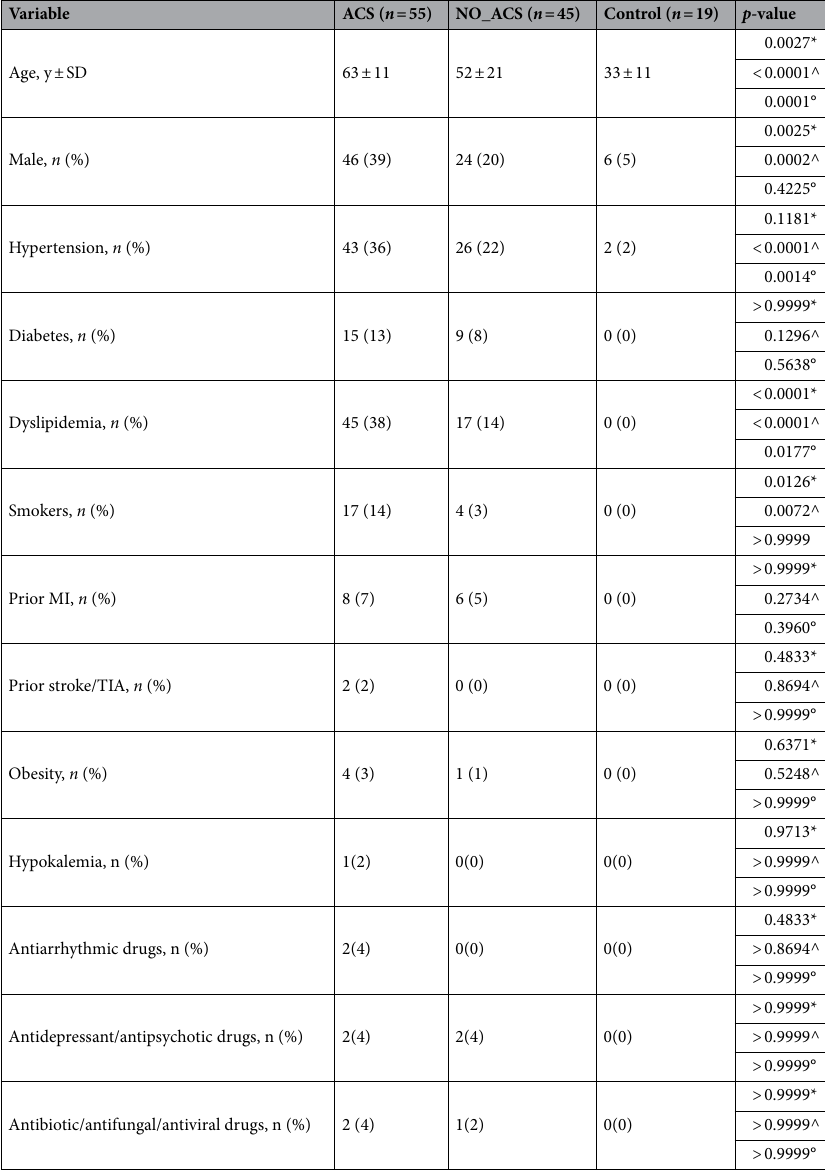
Table 1. Characteristics of the study subjects. ACS acute coronary syndrome, MI myocardial infarction, TIA transient ischemic attack. p-value is to be interpreted as follows: *ACS vs NO_ACS; ^ACS vs CONTROL; °NO_ACS vs CONTROL. A p-value of < 0.05 was considered statistically